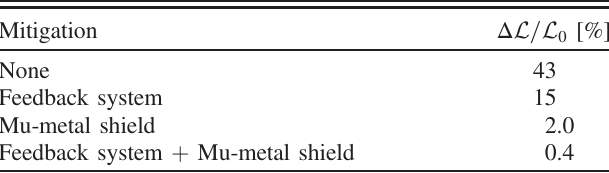
TABLE III. Relative luminosity loss Δ L = L 0 due to stray fields. L 0 is the nominal luminosity of